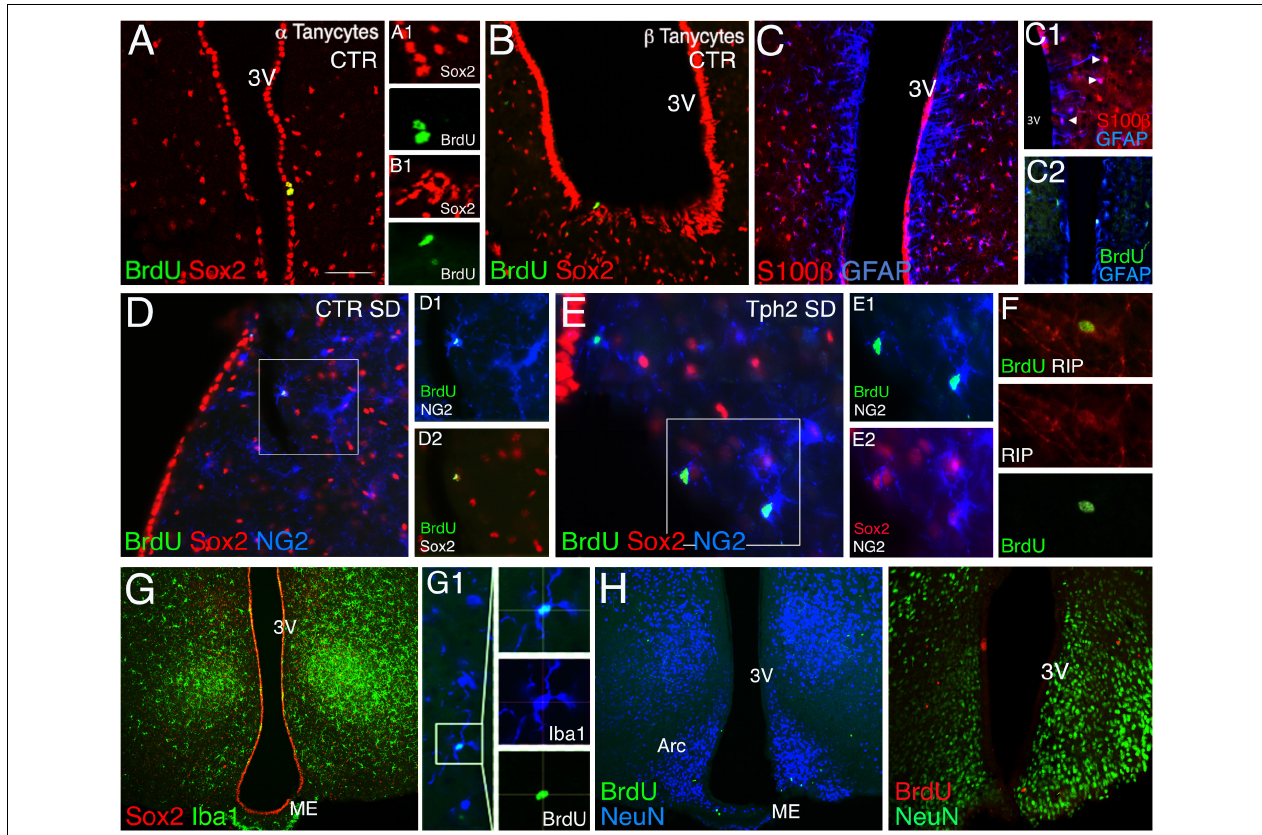
FIGURE 2 | Immunohistochemistry of cell phenotypes. (A,B) In CTR mice, a sparse number of BrdU/Sox2-tanycytes was found lining the third ventricle and was absent in Tph2 − / − mice (Tph2; α tanycyte, A1 , β tanycyte, B1 ) Scale bar 150 µ m. (C) GFAP + cells lining the dorsal part of the ventricle often co-express S100 β , arrowheads (C1) , and were rarely dividing (BrdU/GFAP + , C2 ). (D–F) BrdU/Sox2/NG2 + cells account to ∼ 20% in CTR (D) and ∼ 50% in Tph2 (E) at standard diet, SD. Approx. 30% of these cells followed the oligodendrocyte fate expressing the lineage marker RIP (F) . (G) One third of BrdU + cells adopted a microglia fate in